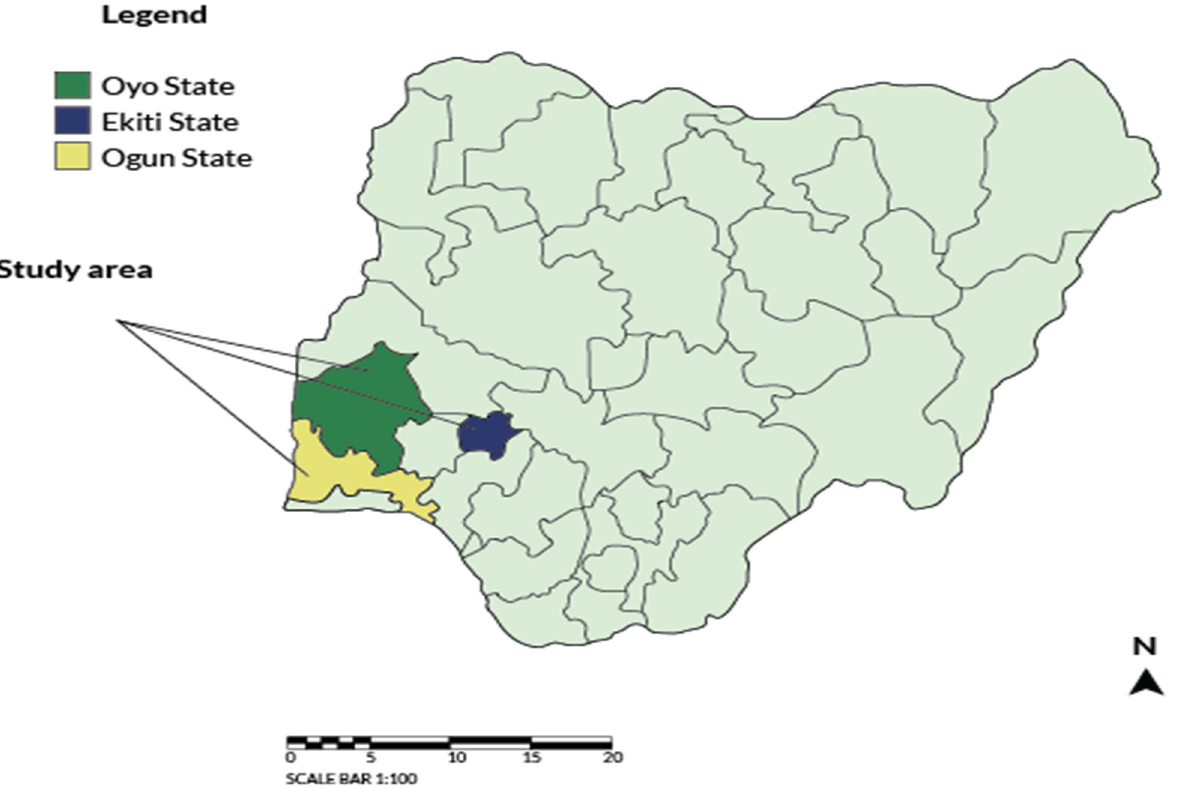
Figure 2. Study areas located within the identified states in the SouthWestern geopolitical zone of Nigeria.